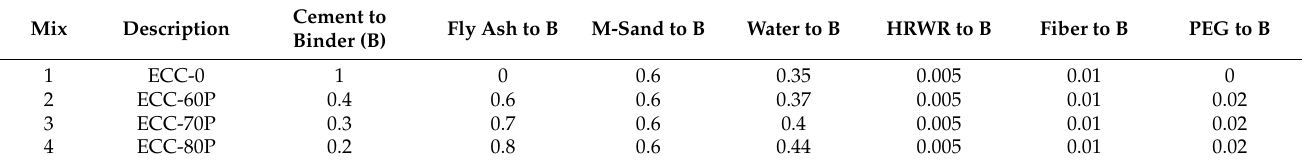
Table 4. Strength of concrete mixes.